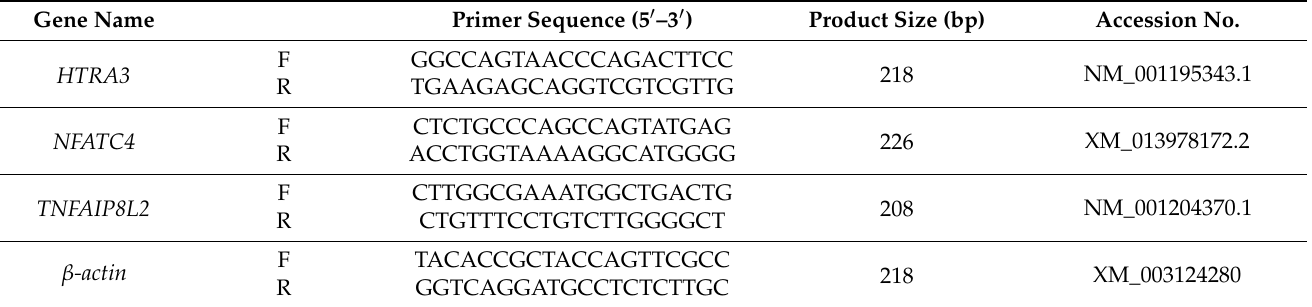
Table 2. Oligonucleotide primers used for quantitative real-time